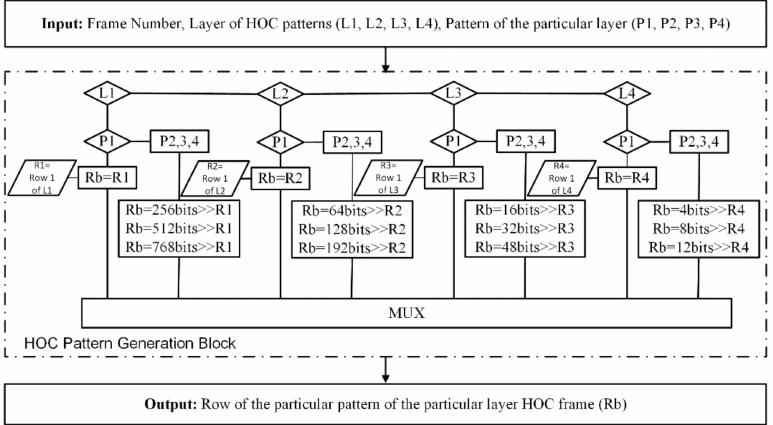
Figure 10. HOC patterns generation module generates patterns from the first row of each layer of HOC patterns by using the register shift